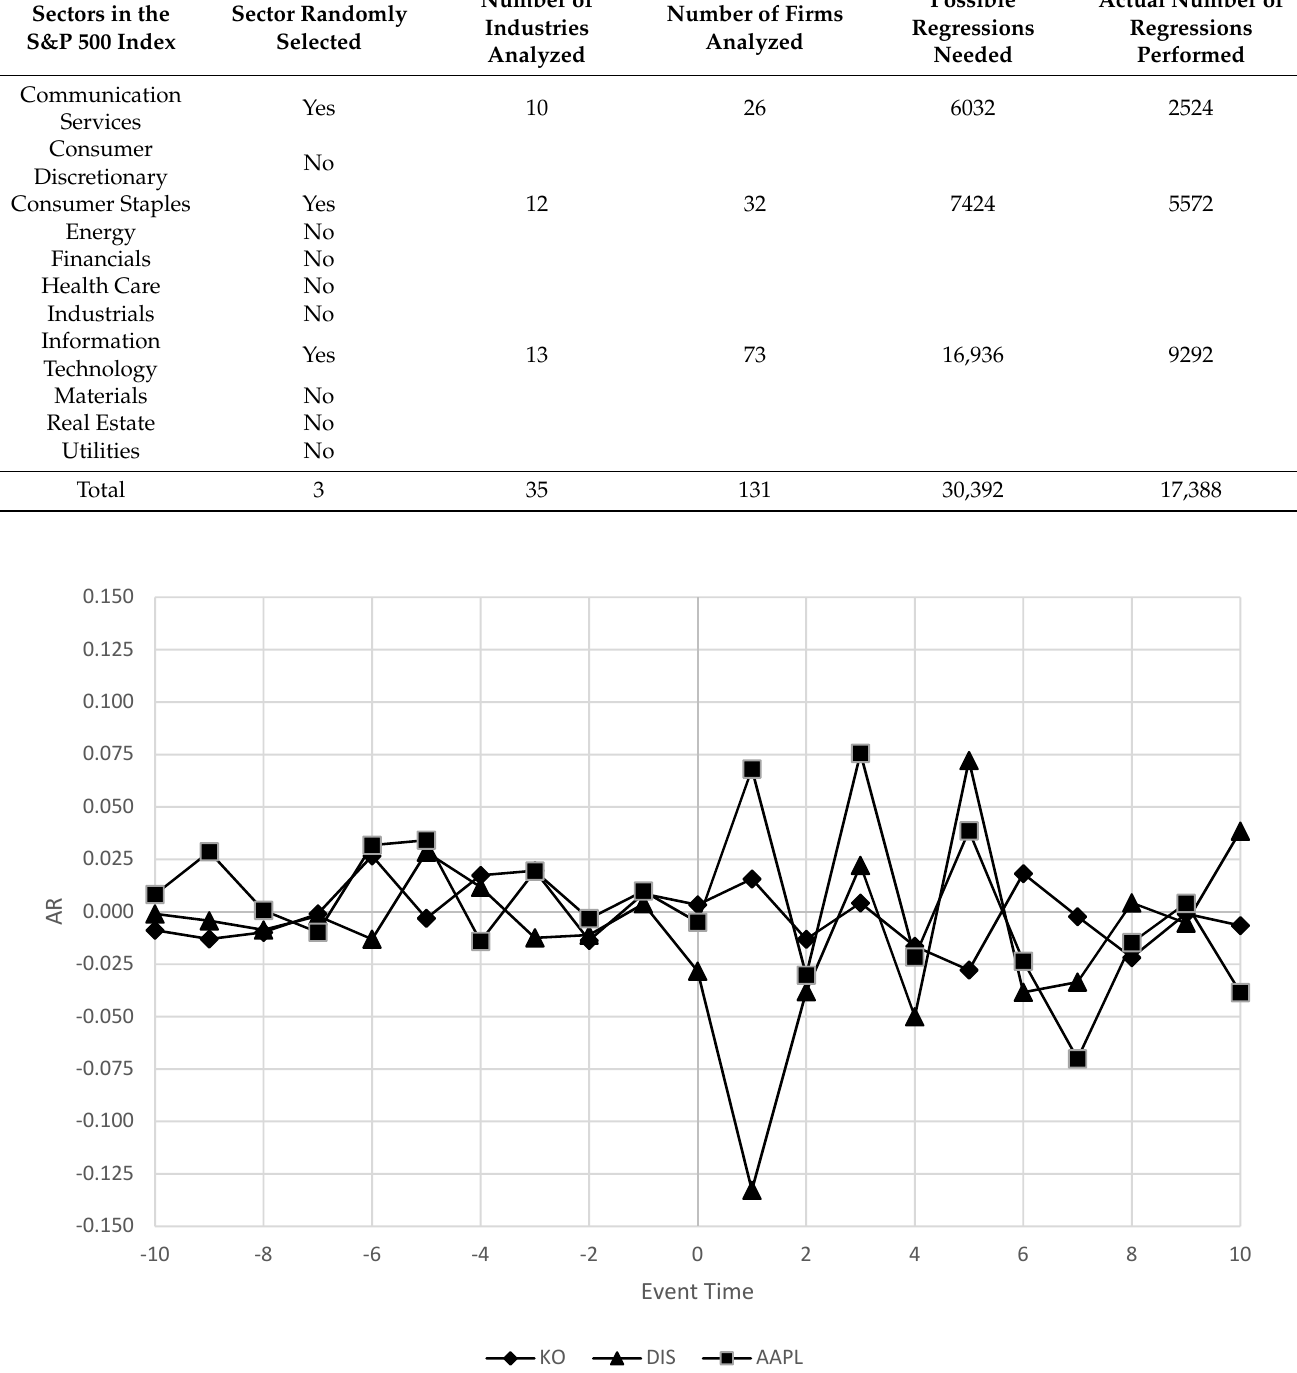
Figure A2. Plot of cumulative abnormal returns for the “9/11” Geopolitical event and event window ( − 10,10).